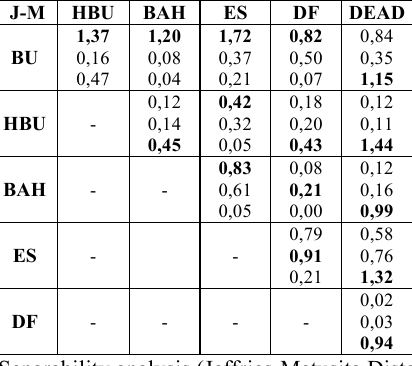
Table 5: Separability analysis (Jeffries-Matusita Distance) for the main tree species (Normalized Difference Green-Red Index for November (above), October(mid) and August (below) 2018 data).